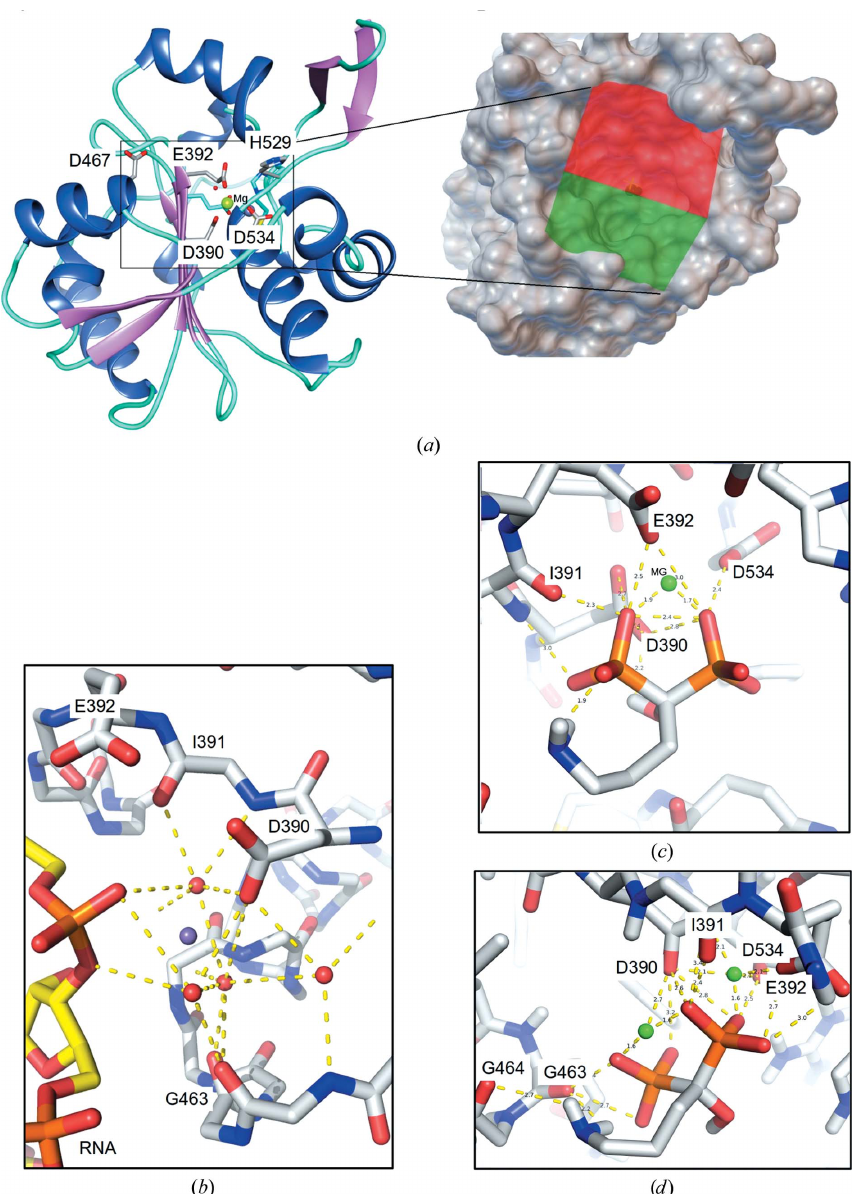
Figure 1 Screening and docking experiments against MOPV NP-exo. ( a ) The crystal structure of MOPV NP- exo used for docking studies (PDB entry 5lrp) presented as a ribbon diagram of the protein with helices in blue, (cid:3) -strands in pink and loops in cyan. Active-site residues are shown with their side chains as sticks (C atoms in gray, O atoms in red and N atoms in blue). The coordination of the Mg 2+ ion (green sphere) is also illustrated. The expanded square corresponds to the red/green box shown on the molecular-surface representation of the MOPV NP-exo structure. It represents the grid box used to define the docking space covering the entire active site. ( b ) Interactions of RNA with the catalytic site of LASV NP-exo and a single Mn 2+ ion (purple sphere; PDB entry 4gv6) for reference. ( c ) Interactions of ALD inside the MOPV NP-exo active site in the presence of a single Mg 2+ ion obtained by AutoDock Vina . ( d ) Interaction of ALD with the MOPV NP-exo model containing two Mg 2+ ions after AutoDock Vina